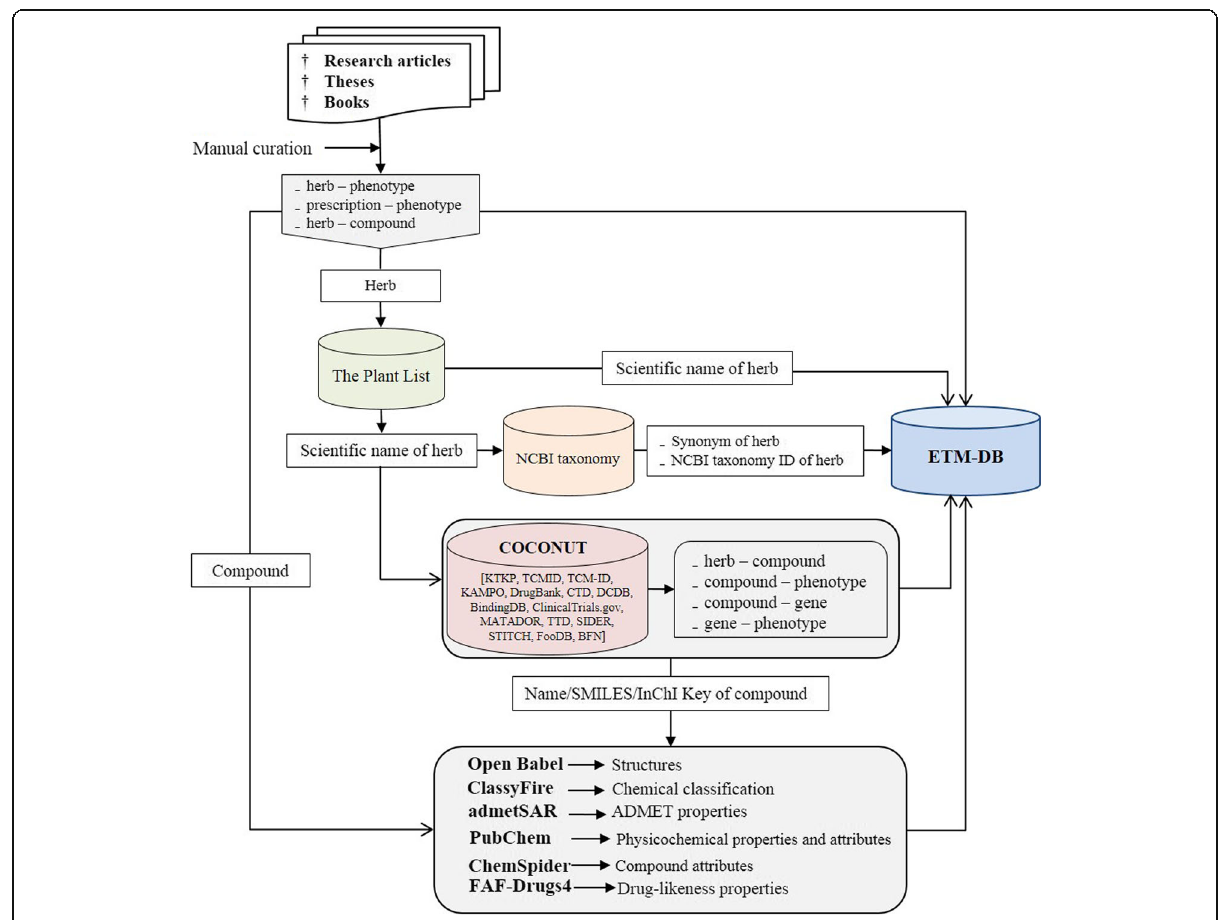
Fig. 1 Illustration of ETM-DB development process. Concisely, we compiled herb-phenotype, prescription-herb, prescription-phenotype, herb- compound, compound-phenotype, compound-gene/protein, and phenotype-gene/protein associations of Ethiopian traditional medicine from literatures and database sources. We organized the information into a relational database. In addition, we used cheminformatics methods to obtain chemical structure, chemical classes, predicted physicochemical, and ADMET properties of the compounds. We also evaluated the drug- likeness of the compounds using the physicochemical